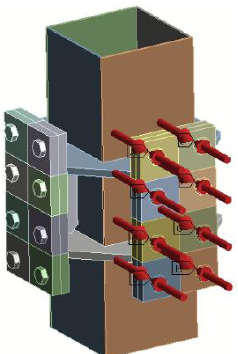
Figure 6. Bolt pretension used in the numerical models.